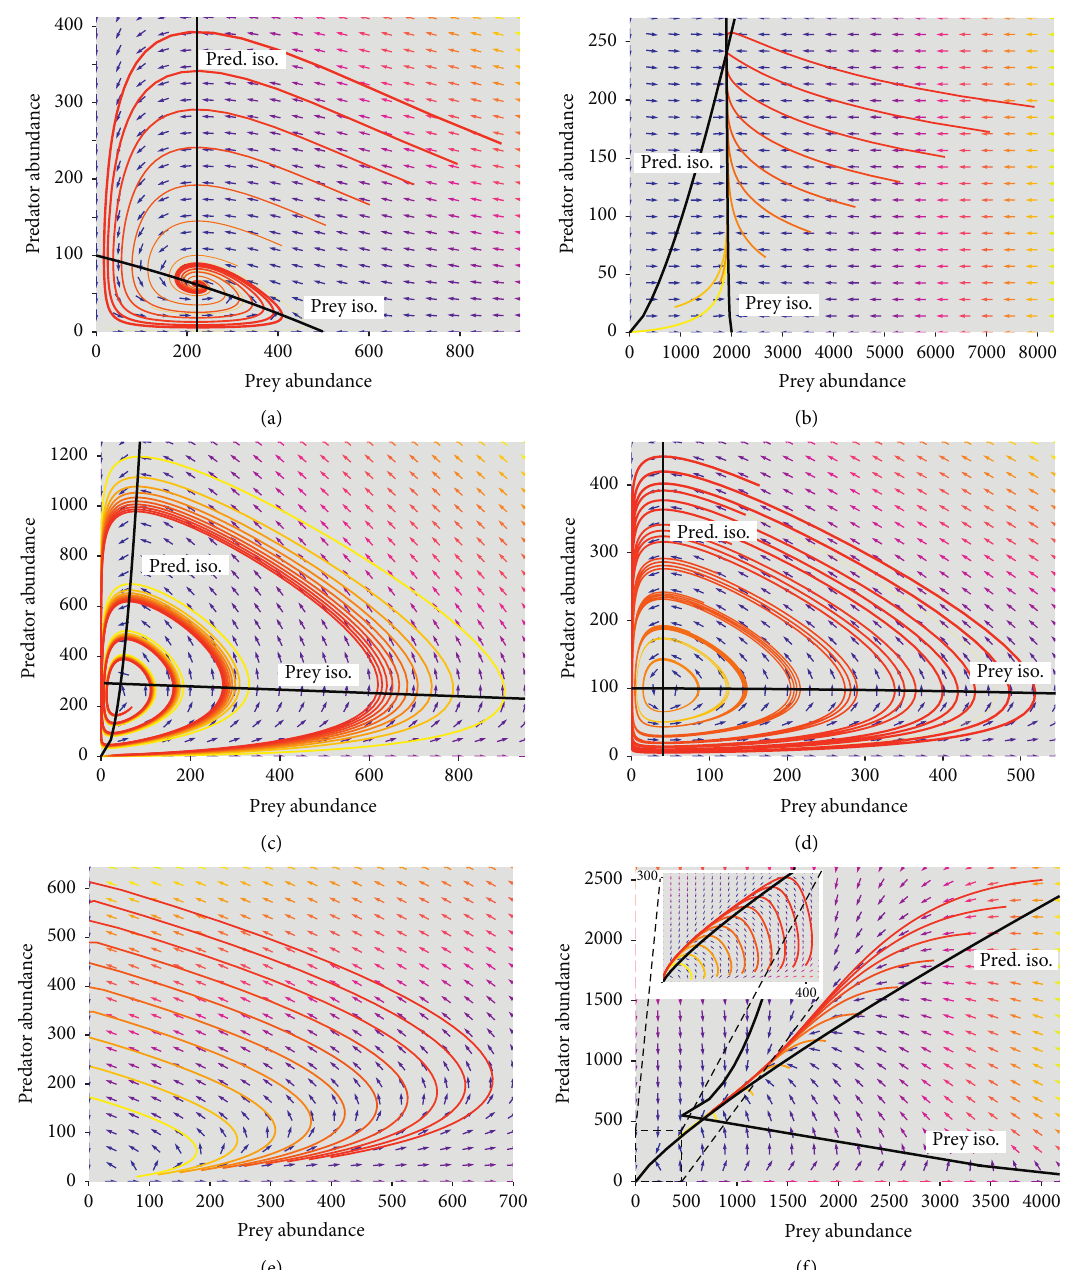
Figure 1: Direction fields and trajectories for different parameterizations of the predator-prey system. Black lines indicate zero-isoclines; their intersections indicate nontrivial equilibria. (a) Prey-dependent system with a global attractor stable equilibrium ( α � 0 . 005 ,b � 0 . 5 ,c � 0 . 5 , d � 0 . 5 ,h � 0 . 1 ,K � 500 ,m � 0). (b) Predator-dependent system with a global attractor stable equilibrium ( α � 0 . 005, b � 0 . 5, c � 0 . 5, d � 0 . 1, h � 0 . 1, K � 2000, m � 0 . 7). (c) Predator-dependent system with unstable equilibrium and limit